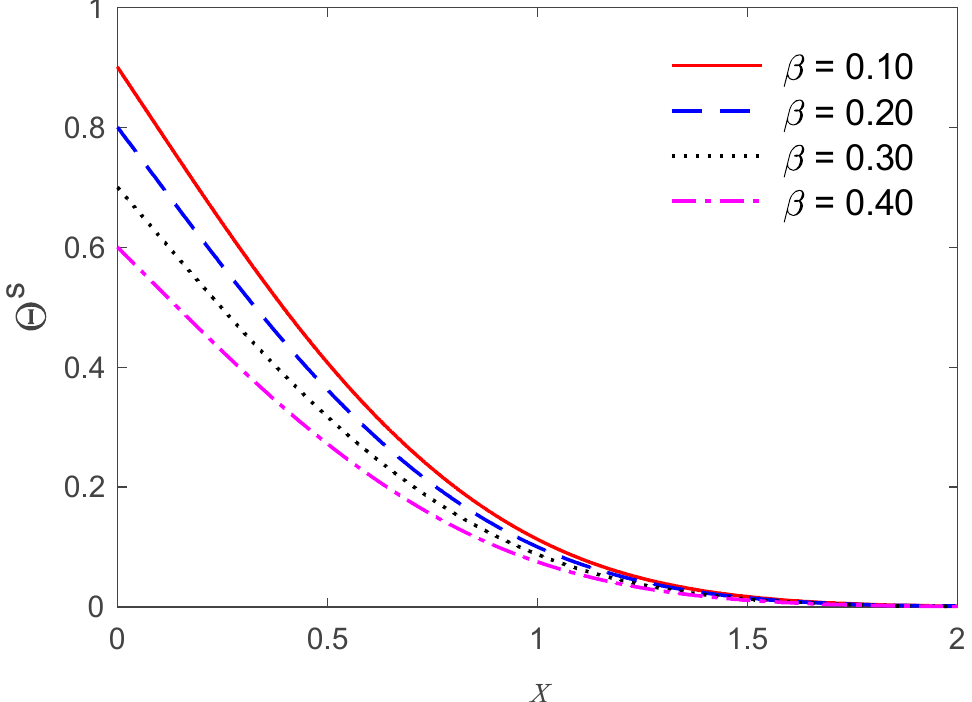
Figure 8. The effects of porosity on the solid temperature variations.